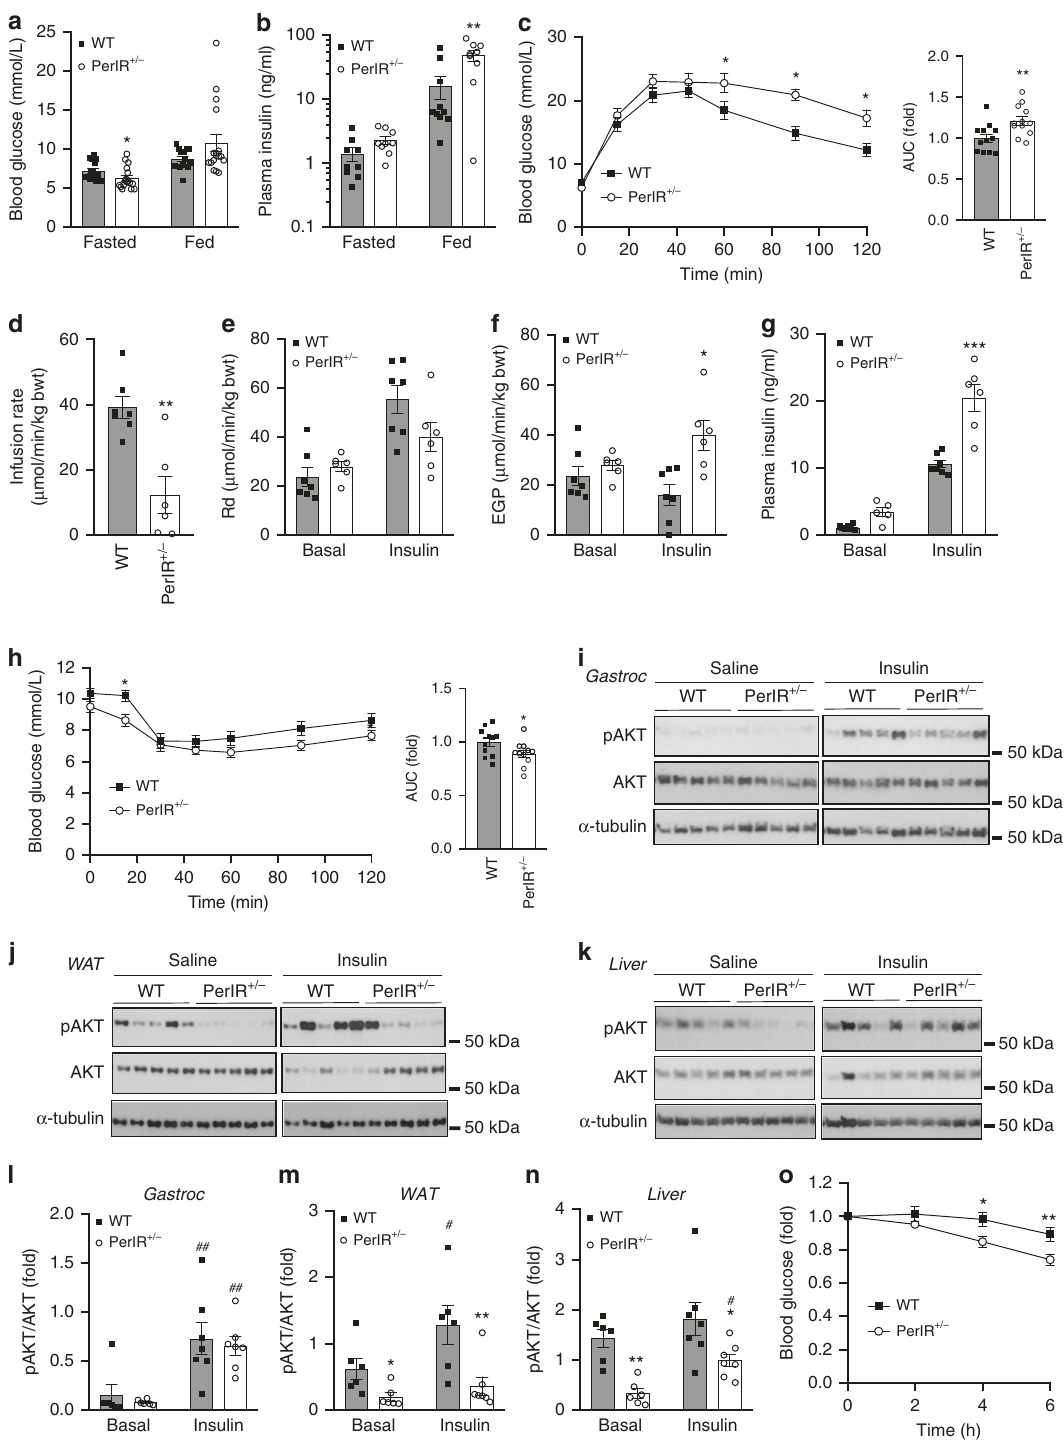
Fig. 2 Partial peripheral tissue IR disruption alters glucose homeostasis in adult mice fed a high-fat diet. Ten days following tamoxifen (TX) treatment, male mice were fed a high-fat diet (HFD) for 10 weeks and blood was collected from fed or 6 h fasted male mice and analyzed for blood glucose or plasma insulin a , b . Glucose homeostasis and insulin sensitivity was assessed via glucose tolerance test (GTT), euglycemic – hyperinsulinemic clamp c – g , insulin tolerance test h , and immunoblot analysis of Ser-473 phosphorylated AKT (pAKT) and total AKT and α -Tubulin ( α -Tub) in gastrocnemius (Gastroc) muscle i , l , white adipose tissue (WAT) j , m and liver k , n from WT and PerIRKO + / − mice injected (intraperitoneal) with saline or insulin (0.6 mU/g). Blood glucose was monitoring during 6 h of fasting following a meal challenge o . Results are shown as means ± SE, with n ’ s represented as individual data point ’ s in fi gures. For fast-refeed n = 13 for WT and 17 for PerIRKO + / − . Signi fi cance was determined using two-tailed student ’ s t test or ANOVA with LSD post hoc analysis. * p < 0.05, ** p < 0.01, vs WT, and # p < 0.05, ## p < 0.01 for within genotype effect. Rd: rate of glucose disappearance, EGP: endogenous glucose production, AUC: area under